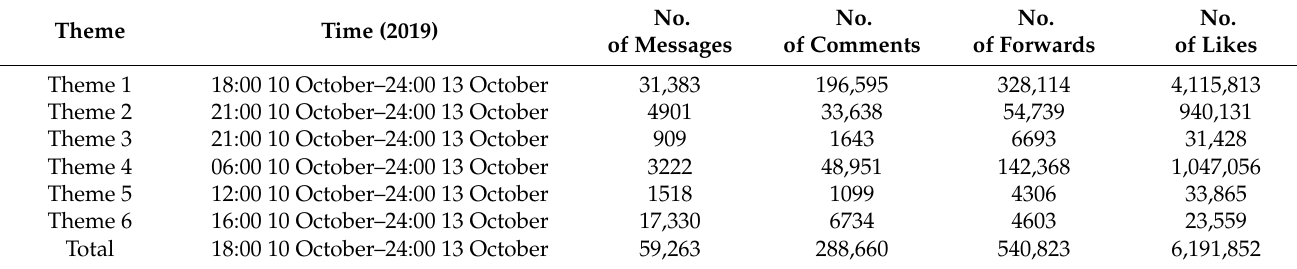
Table 1. Basic statistics for the accident-related